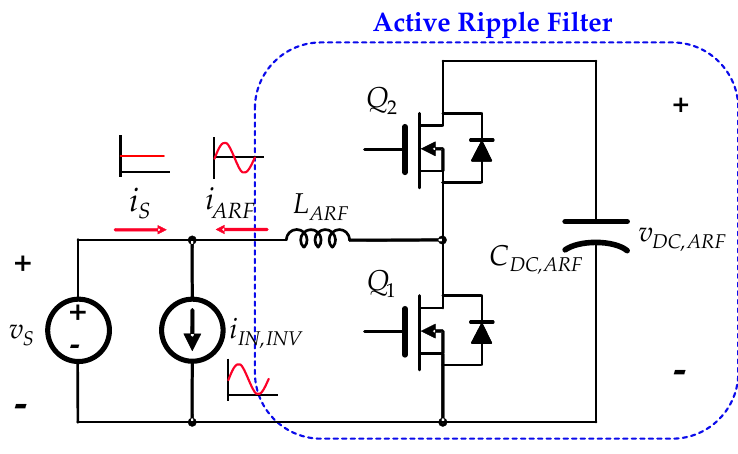
Figure 4. Circuit architecture of the ARF.